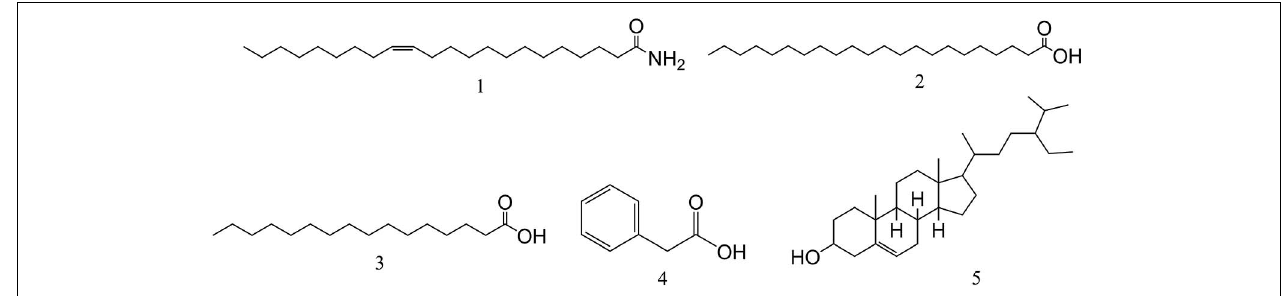
FIGURE 3 | The chemical structures of compounds isolated from L2. Compounds 1 ∼ 5 are erucamide, behenic acid, palmitic acid, phenylacetic acid, and β -sitosterol, respectively.